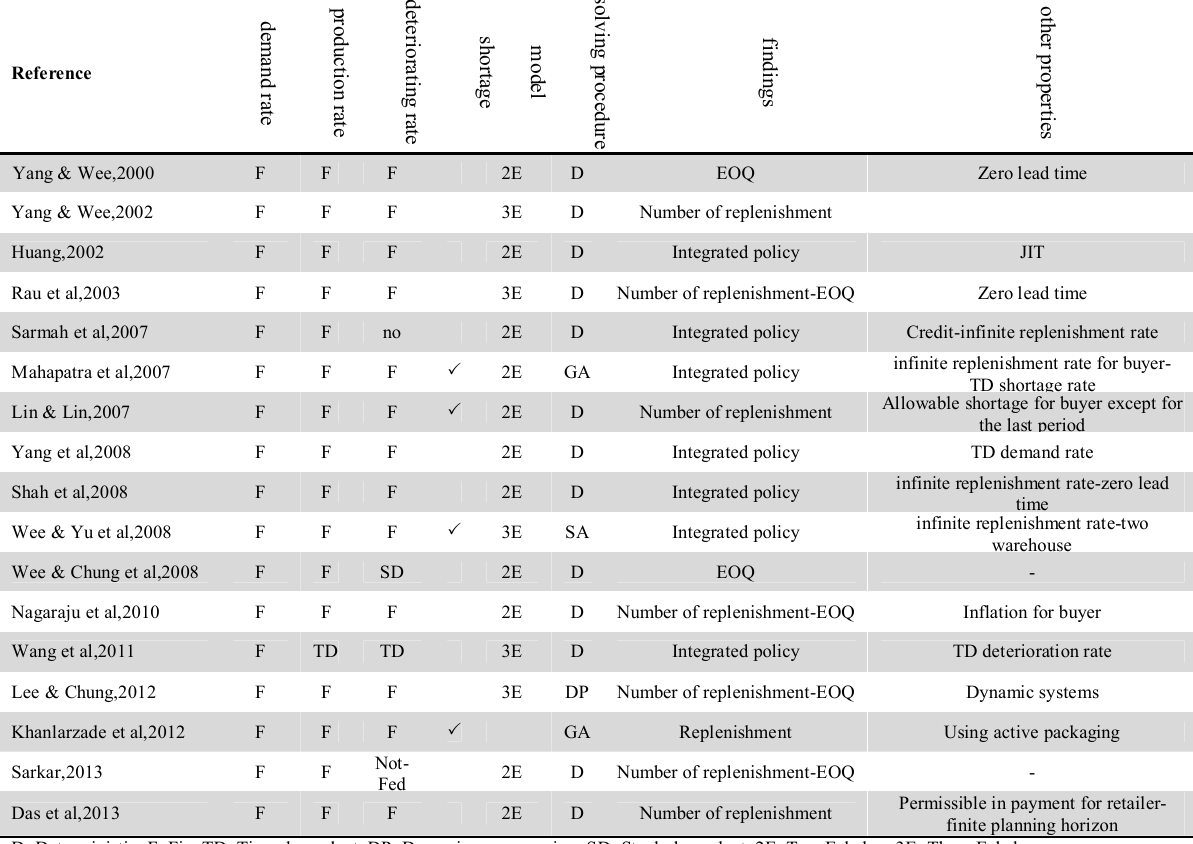
Classification of deteriorating inventory control for multi-echelon supply